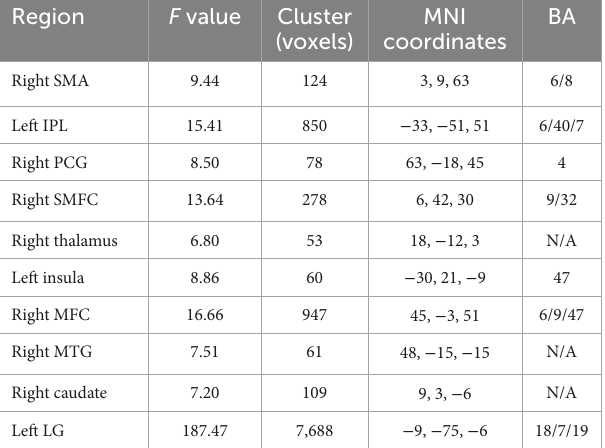
TABLE 2 Differences of task-related brain activation across the four decks.